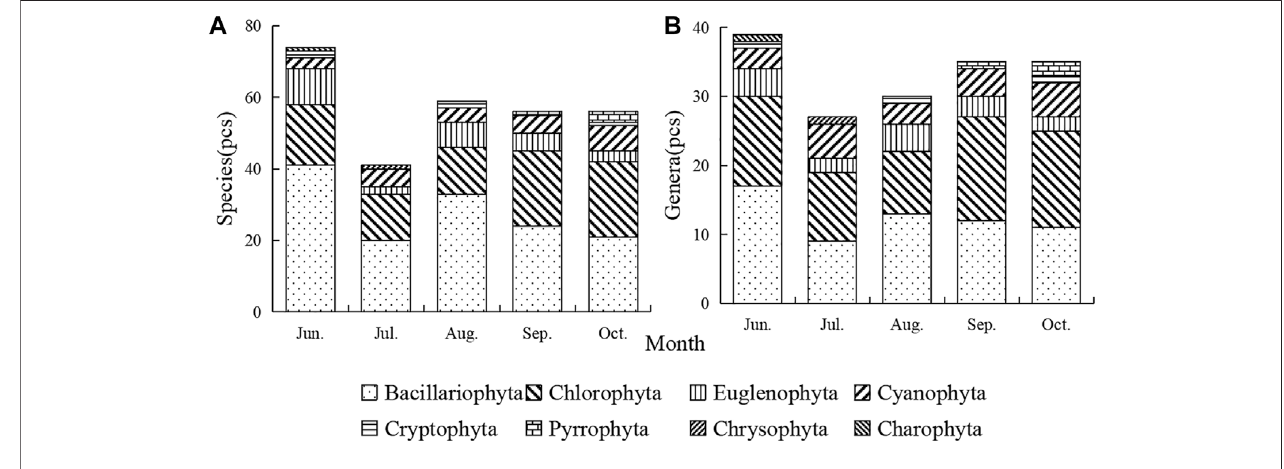
FIGURE 3 | Temporal variation of phytoplankton species (A) and genera (B) .